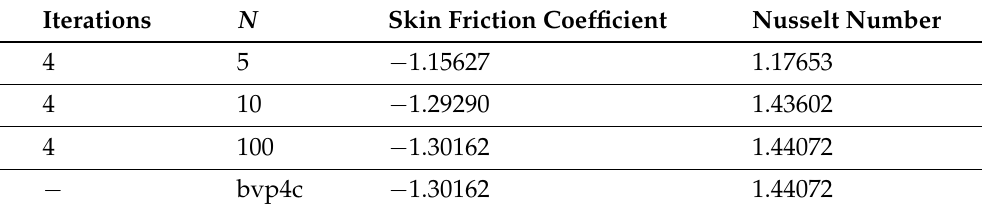
Table 3. Impact of varying N on skin friction coefficient and Nusselt number.